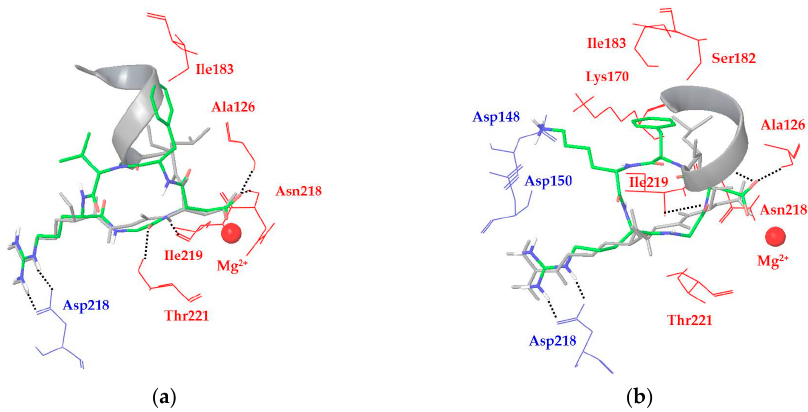
Figure 2. Docking best poses of ( a ) ligand 1a (green) and ( b ) ligand 1c (green) overlaid to the X-ray structure of the TGF- β 3 undecapeptide (grey, α -helix represented as a ribbon) into integrin α V β 6 (from 4UM9.pdb). Only selected integrin residues involved in interactions with the ligand are shown and labeled in blue for α V and red for β 6 . Non-polar hydrogens are hidden for clarity, while intermolecular hydrogen bonds are shown as black dashed lines.